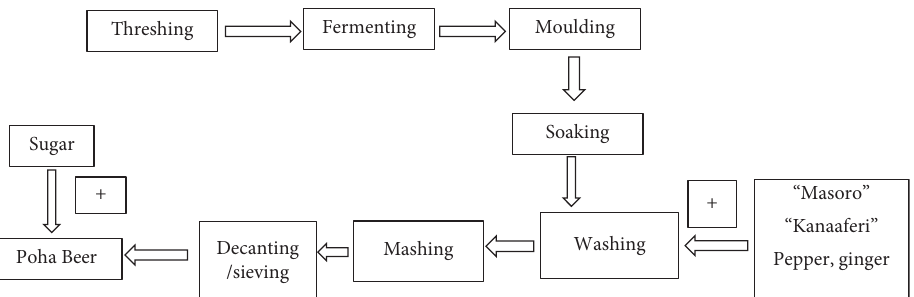
Figure 1: Schematic representation of the preparation of Poha Beer. Poha Beer is brewed in six distinct steps, which include the following. Threshing: due to its sticky nature, the outer case of the fruit is manually removed with care in order to prevent contact with particles. Fermentation: the fruits are sprinkled with water and allowed to stand for 24 h for fermentation to occur. Moulding: the fruits are preserved by moulding into balls and stored until required for use. Moulding reduces the surface area and prevents development of bacterial and fungal spores. Soaking: the fruits are soaked with either cold or warm water for between ∼ 4 and 12h to ensure efficient pulp extraction and dissolution. Mashing: in order to efficiently extract a high amount of pulp, the soaked fruits are mashed with clean hands, after which the required spices such as the local spices (“masoro” and “kanaaferi,” with pepper, ginger, and lime) are added. Decanting: the mashed mixture is then sieved, after which sugar is added to the filtrate, bagged, and sold to consumers by street vendors.